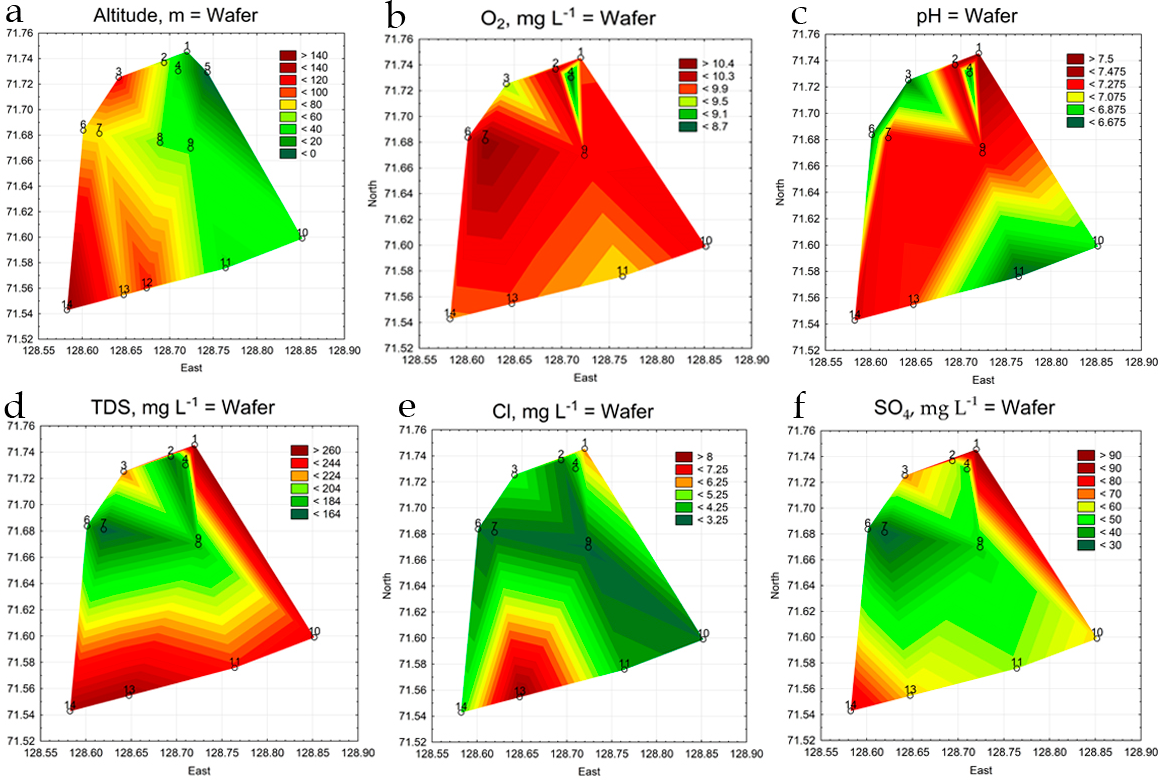
Figure 6. Statistical maps of environmental variables in the 11 studied water bodies: ( a ) altitude; ( b ) oxygen; ( c ) pH; ( d ) TDS; ( e ) chlorides; ( f ) sulfates.